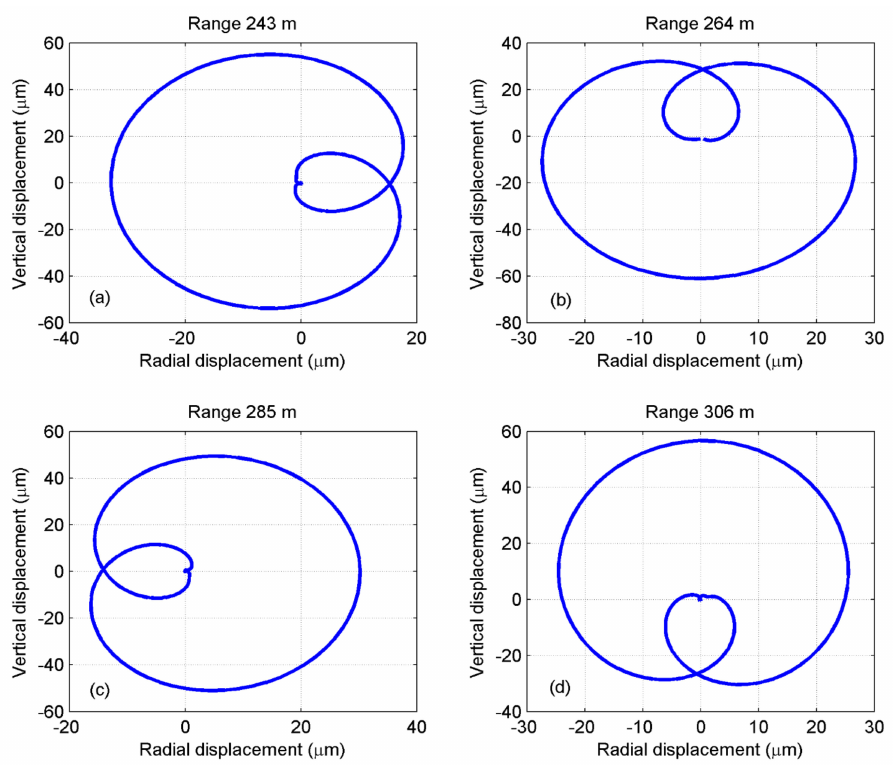
Figure 15. Four successive hodographs show the changes during the morphing process at ranges 243 m, 284 m, 285 and 306 m in plots ( a ) to ( d